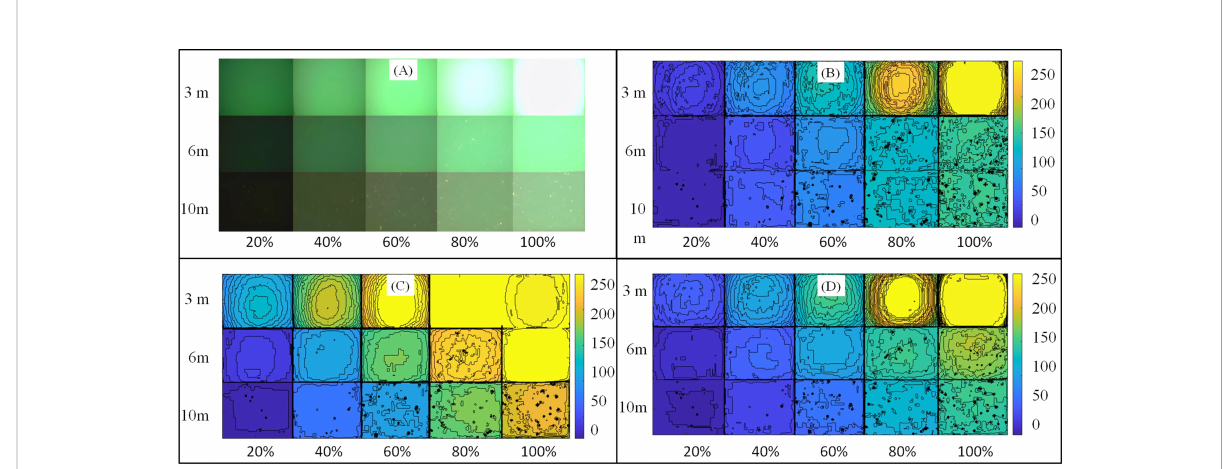
FIGURE 11 The experimental results of deep-sea lighting design. (A) the raw experiment picture data; (B) the illumination distribution in red wavelength band; (C) the illumination distribution in green wavelength band; (D) the illumination distribution in blue wavelength